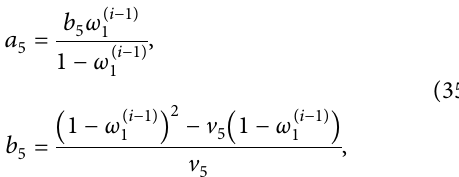
Figure 3: Plots of ML results for two-component models showing the ML estimates (red points) with approximate 95% confidence fields (gray areas), and the border interval is marked (green lines) for different samples: (a) case 1, (b) case 2, and (c) case